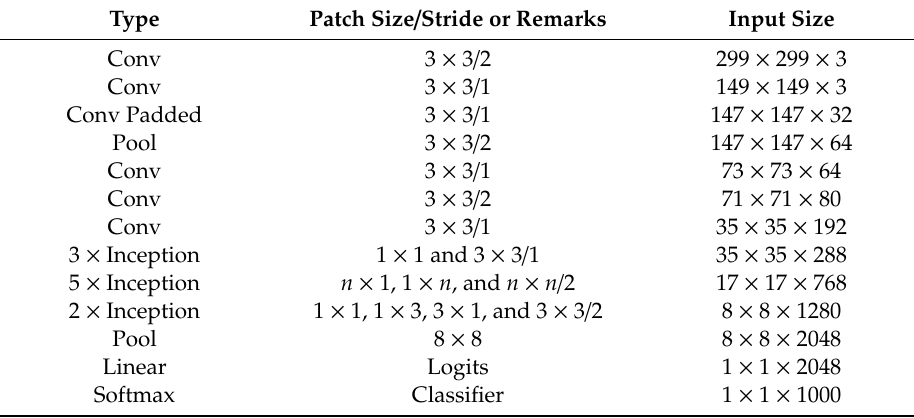
Table 1. The outline of the Inception-v3